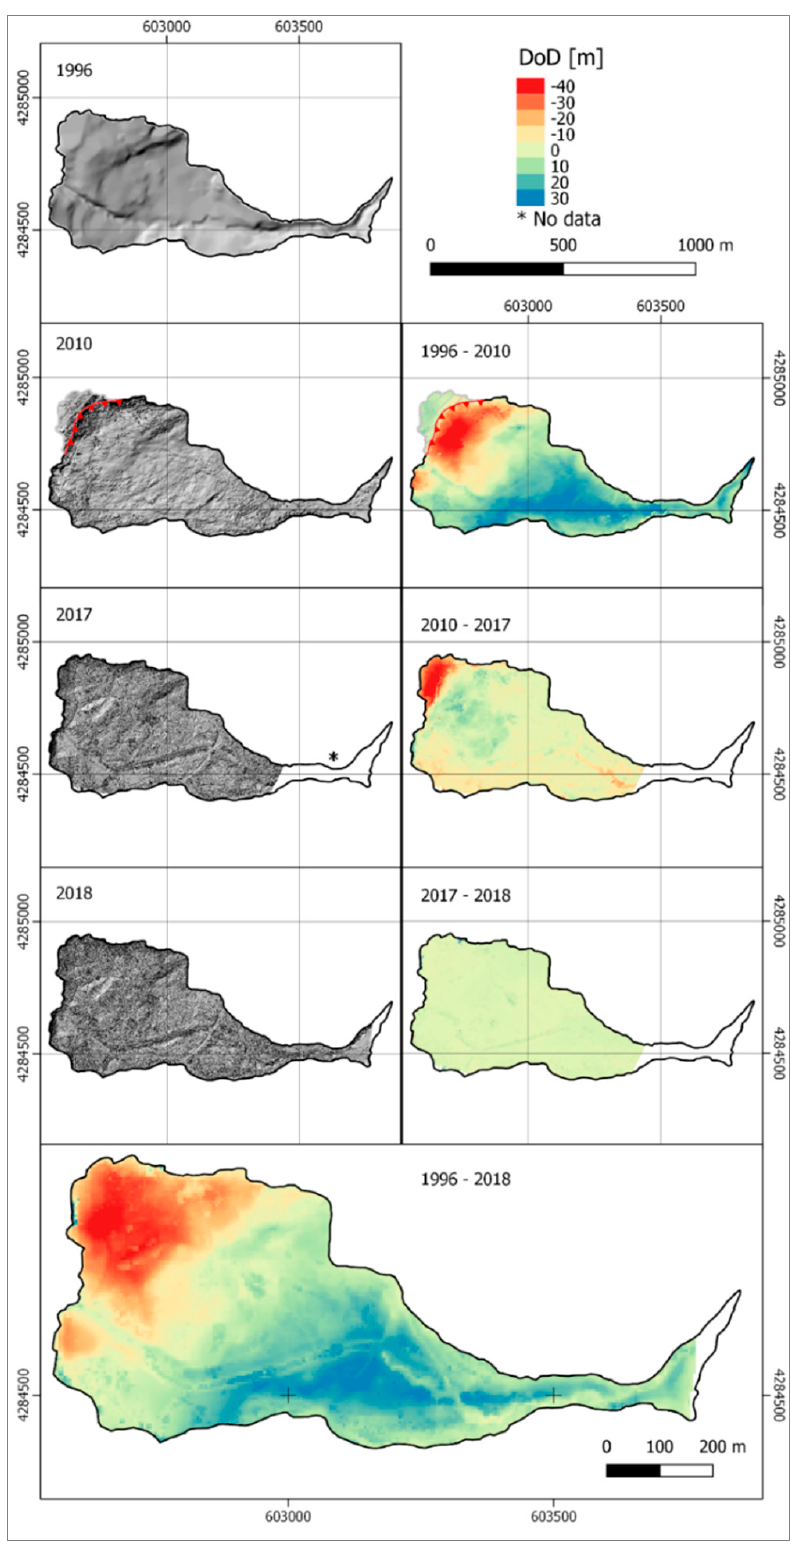
Figure 7. Hillshades (left) and DEM of differences (DoDs) (right) of the landslide (RS: UTM WGS84—Zone 33N; EPSG code 32633). The red line in the 2010 hillshade and in the 1996–2010 DoD represent the landslide scarp of 15 February 2010.